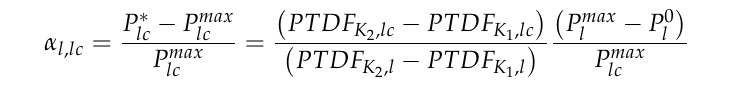
Figure 7. Relationship between the saturation of the congested line and other lines. Then, we define the parameter α l,lc , which represents the oversaturation in line lc when line l gets